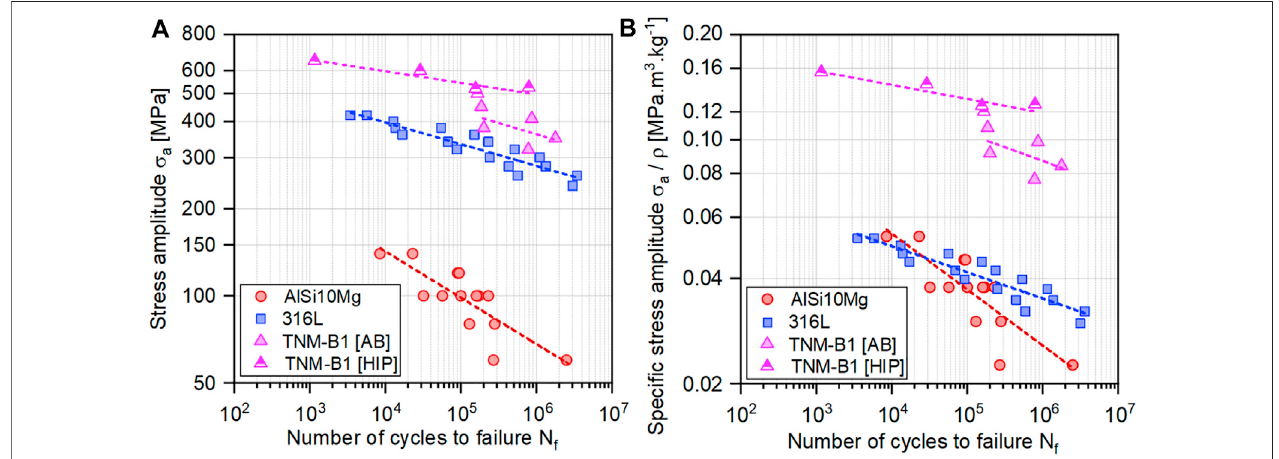
FIGURE 2 | (A) Woehler diagrams; (B) speci fi c Woehler diagrams for AlSi10Mg, 316L (Kotzem et al., 2021; Stern et al., 2022), and TNM-B1 (Teschke et al., 2022) alloys.